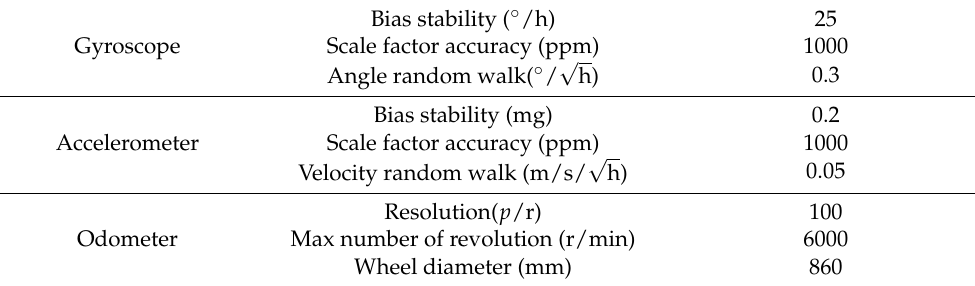
Figure 7. Integrated navigation and data acquisition system. Table 1. Sensor specifications.